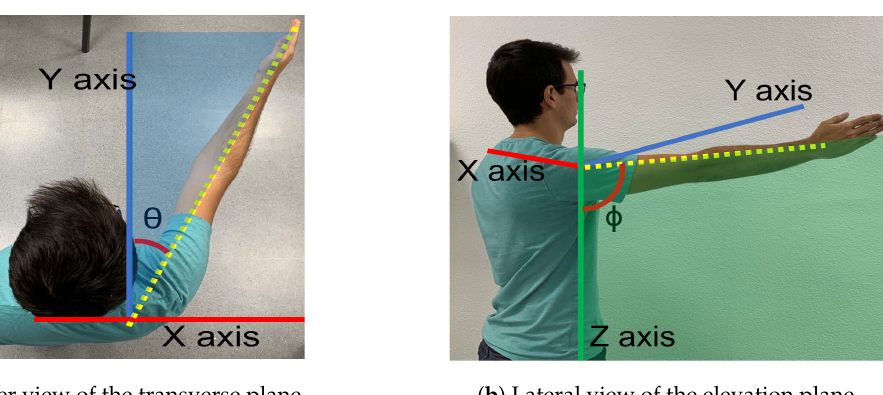
Figure 3. Motion planes. ( a ) The angle ( θ ) between the arm and the sagittal plane along the transverse plane determines the elevation plane. ( b ) The angle φ is the elevation angle of the arm in the elevation